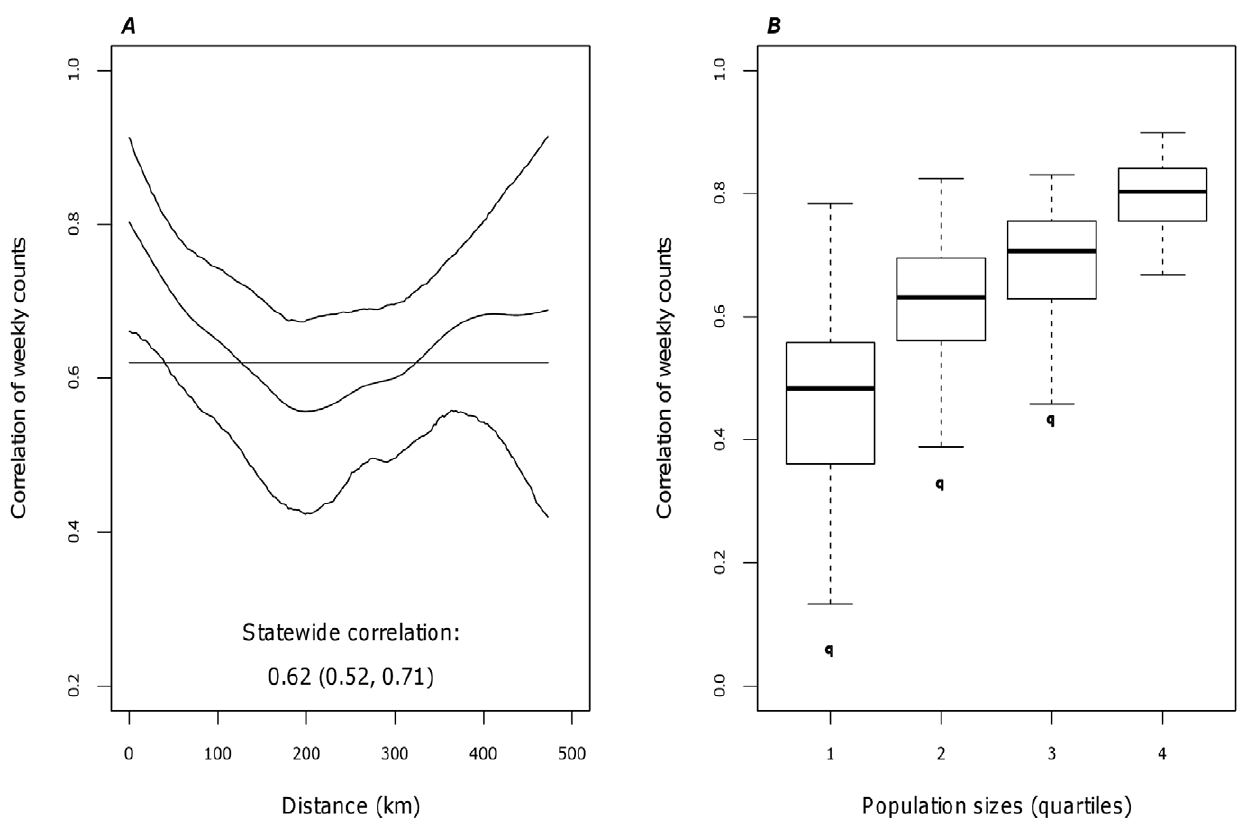
Figure 3. Correlation of weekly time series with distance and population size. A) Synchrony as a function of distance. The spline function (middle curve) is presented with a 95% confidence interval (outer curves). B) Synchrony as a function of population size (product of population i, j). The distribution of population was categorized by quartile. The boxplot within each quartile represent the distribution of the correlation of population between pairs of counties.